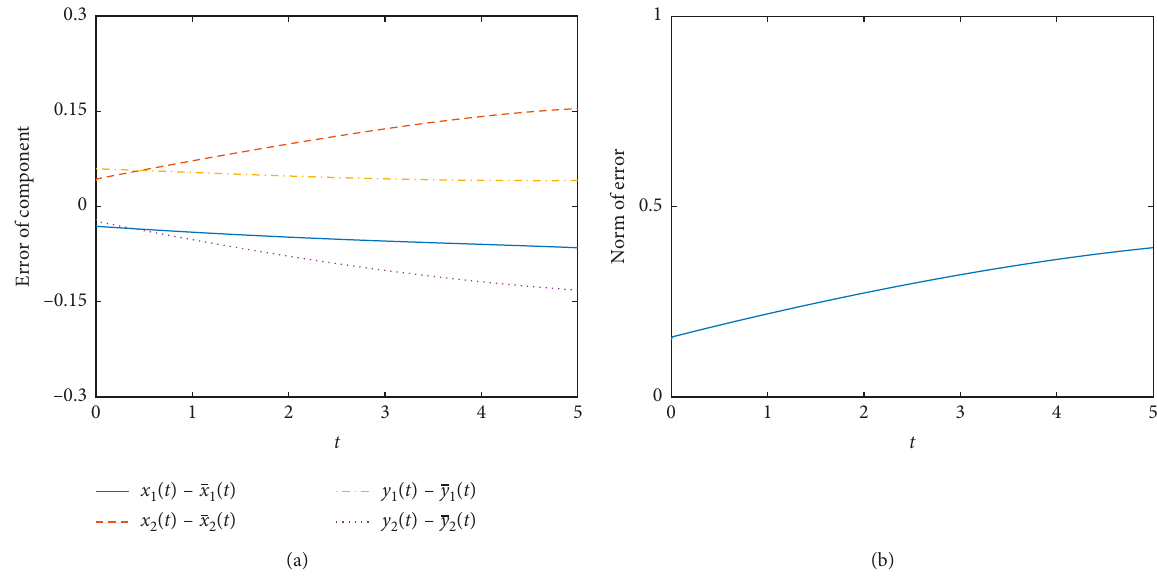
Figure 2: (a) State trajectories of error system in Example 1. (b) Time evolution for the norm of error in Example